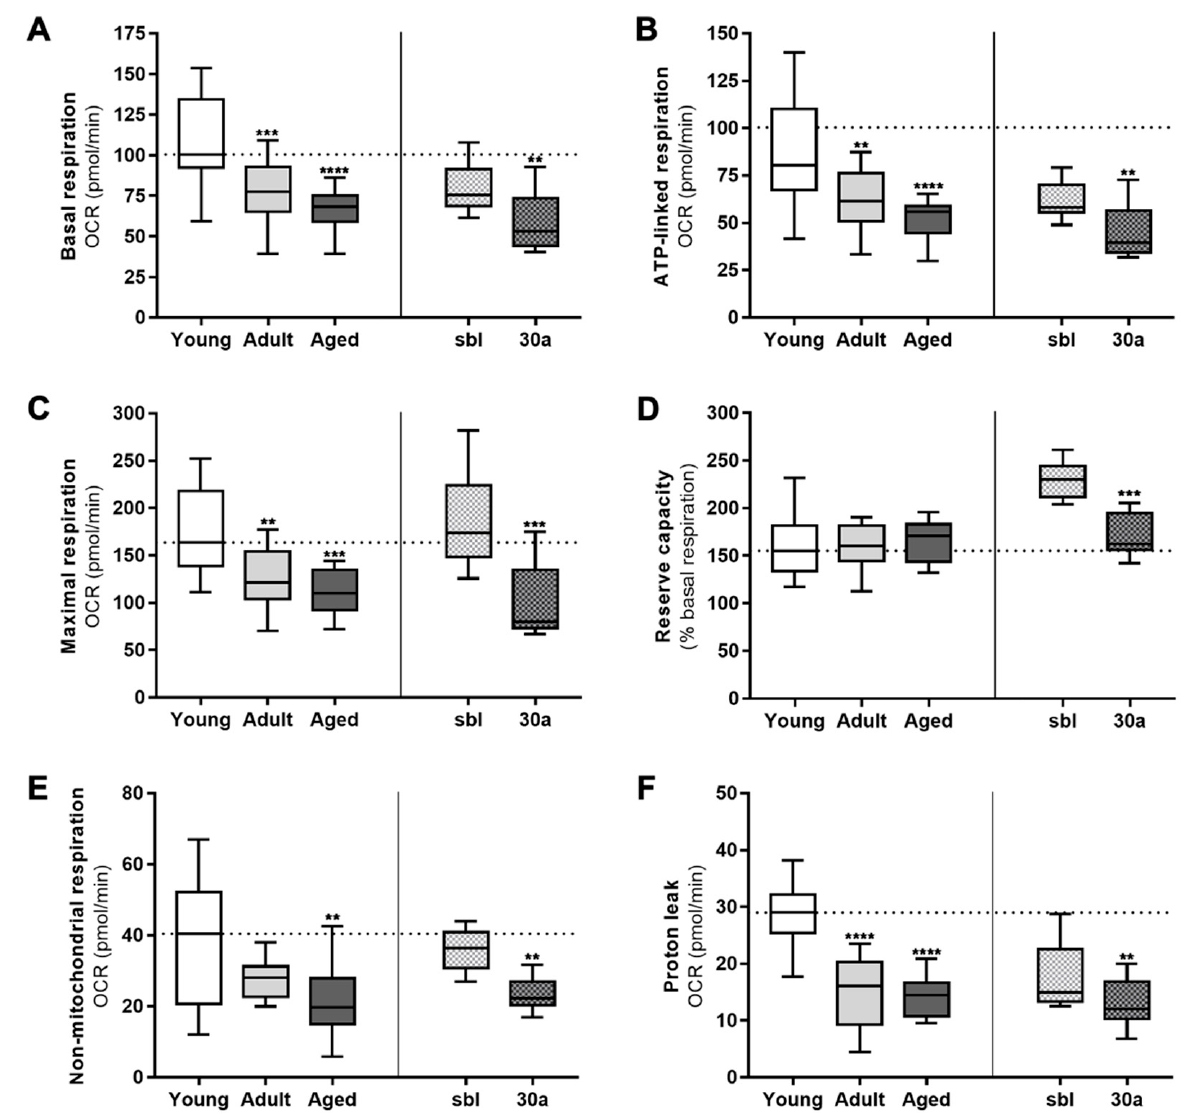
Figure 5. Mitochondrial metabolic activity of keratinocytes from different age groups and after overexpression of miR-30a. Major aspects of mitochondrial coupling and respiratory control were measured using the Seahorse Bioanalyzer and determined by the sequential additions of oligomycin, an ATP synthase inhibitor, FCCP, a protonophoric uncoupler, and rotenone and antimycin A, two inhibitors of the electron transport chain. sbl: miR-scrambled; 30a: miR-30a. Basal respiration ( A ), ATP-linked respiration ( B ), maximal respiration ( C ), reserve capacity ( D ), non-mitochondrial respi- ration ( E ) and proton leak ( F ) were determined by measuring the Oxygen Consumption Rate (OCR) in the culture media (median ± SD; young group: n = 6; adult group: n = 6; aged group: n = 5; sbl group: n = 3; 30a group: n = 3; ** p < 0.01, *** p < 0.001 and **** p < 0.0001). Exact p -values were